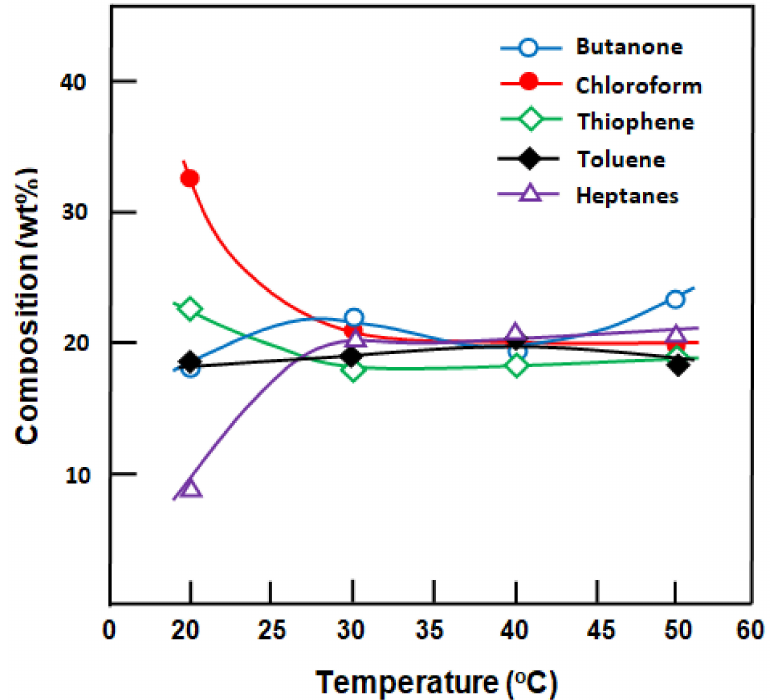
Figure 12. Variation of the concentration of various components in the organic mixture as a function of temperature during the 1.5 h separation